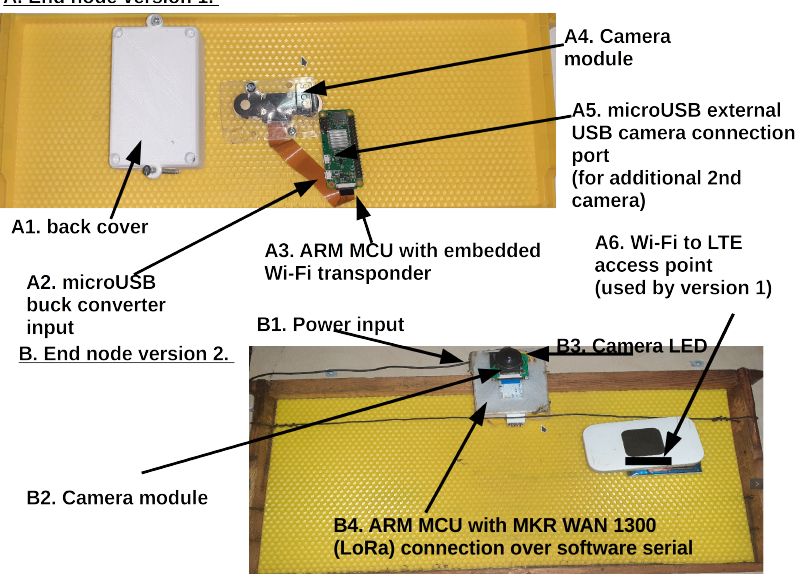
Figure A6. BeeQ RMS end node device prototypes (Version 1 using WiFi and LTE for images’ data transmissions to the BeeQ RMS swarming detection service and the Version 2 device, which transmits the detection results over